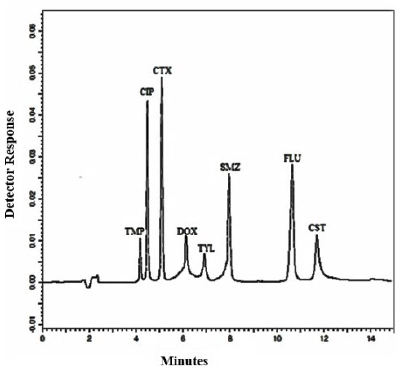
Figure 3. HPLC-UV chromatogram of 20 µL injection of synthetic mixture of 4 µg mL −1 of TMP, CIP, CTX, DOX, CST, 6 µg mL −1 of TYL, and 2 µg mL − 1 of SMZ, and FLU.